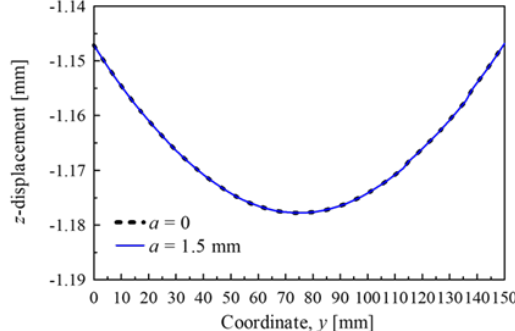
Figure 18. The z -displacement of the surface of Model 3D along trace line 3. The z -displacement implies the change in z -direction due to loading.